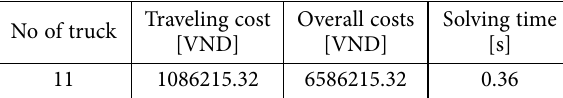
Table 7. Computational results according to capacitated k -means clustering algorithm (source: current